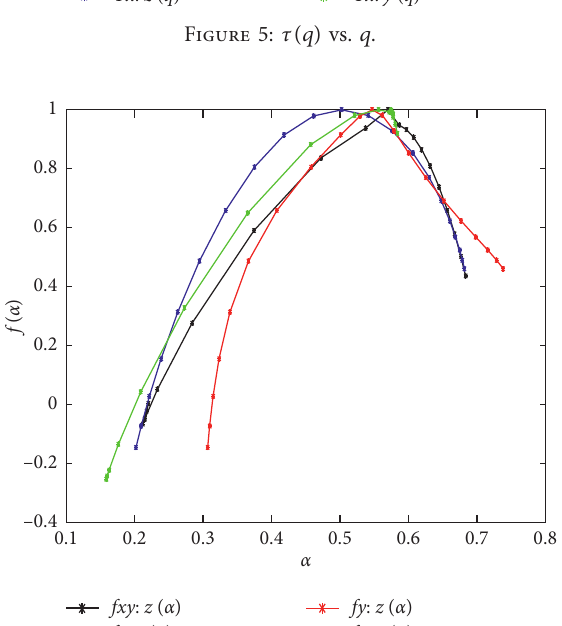
Figure 5: τ ( q ) vs. q